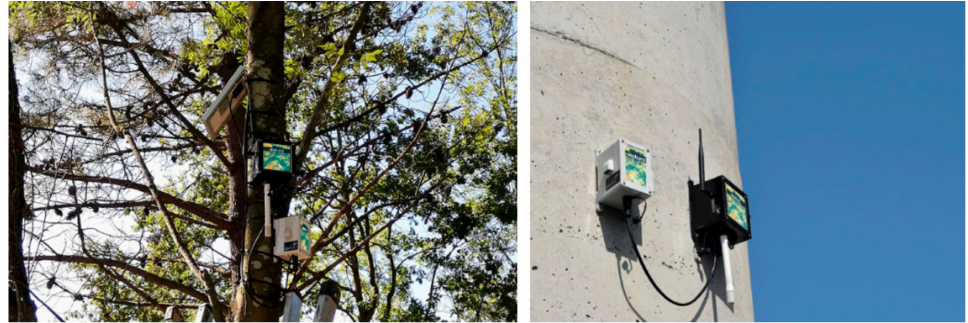
Figure 9. Details of the location of the air quality control sensors of the South Metropolitan Bypass.